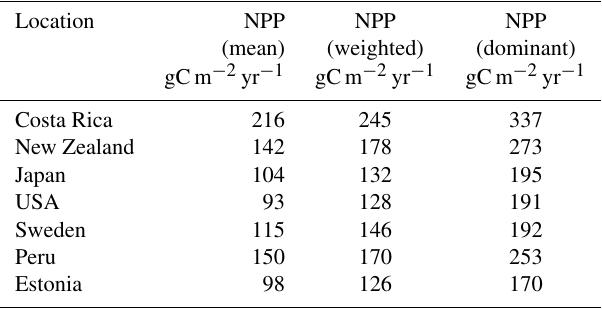
Table A1. Comparison of NPP: (i) mean, which refers to the av- erage of all surviving species; (ii) weighted, according to Eq. (24), averaged by root and leaf biomass; (iii) dominant species at the lo- cation which accumulates the maximum biomass during the simu- lation period in gram carbon per square meter per